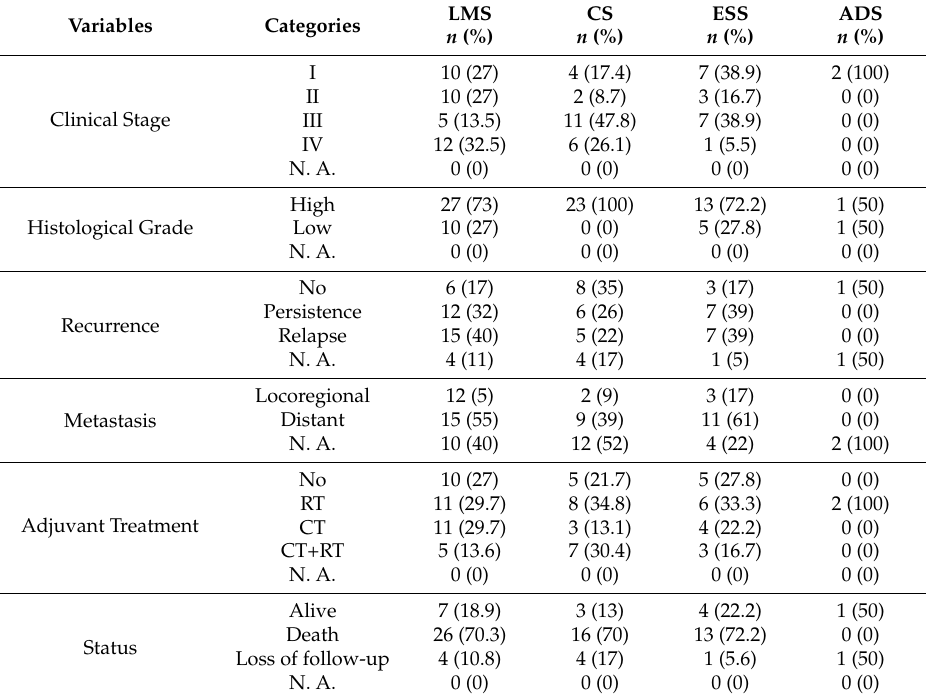
Table 2. Clinical and anatomopathological aspects according to the histological type of neoplasia ( n = 80) *.